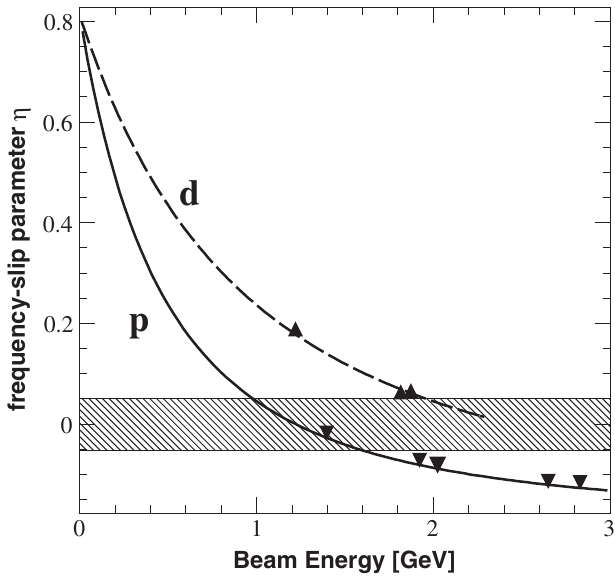
FIG. 11. Frequency-slip parameter (cid:6) as a function of the energy of proton and deuteron beams. The experimental points are the results of ANKE measurements during diverse beam runs. These are compared with curves corresponding to the predictions of COSY lattice calculations. The shaded area shows the region with j (cid:6) j < 0 : 05 where the error in the energy-loss technique can be